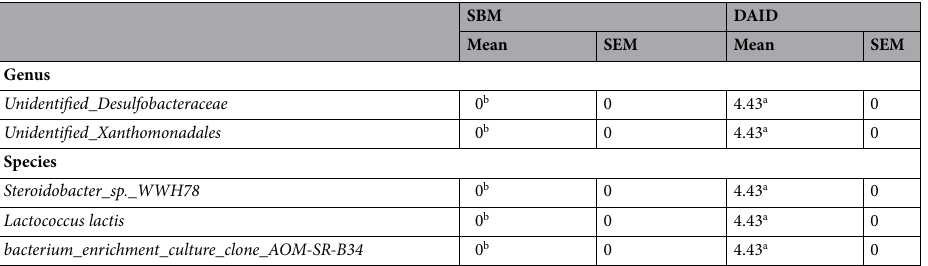
Table 1. The MetaStat analysis of intestinal microbiota of turbot at genus and species levels (× 10 −5 ). Values shared different letters in the same row are significantly different (q-value (corrected p value) < 0.05), n = 3. FM fish meal diet, SBM soybean meal diet, DAID 40 mg/kg daidzein included into SBM diet.